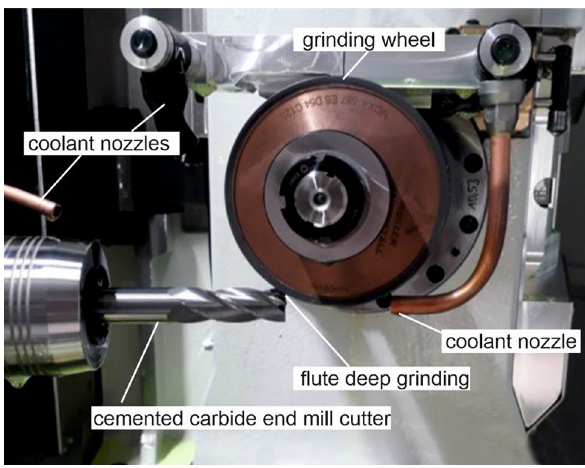
Fig. 2 Deep grinding of a cemented carbide end mill